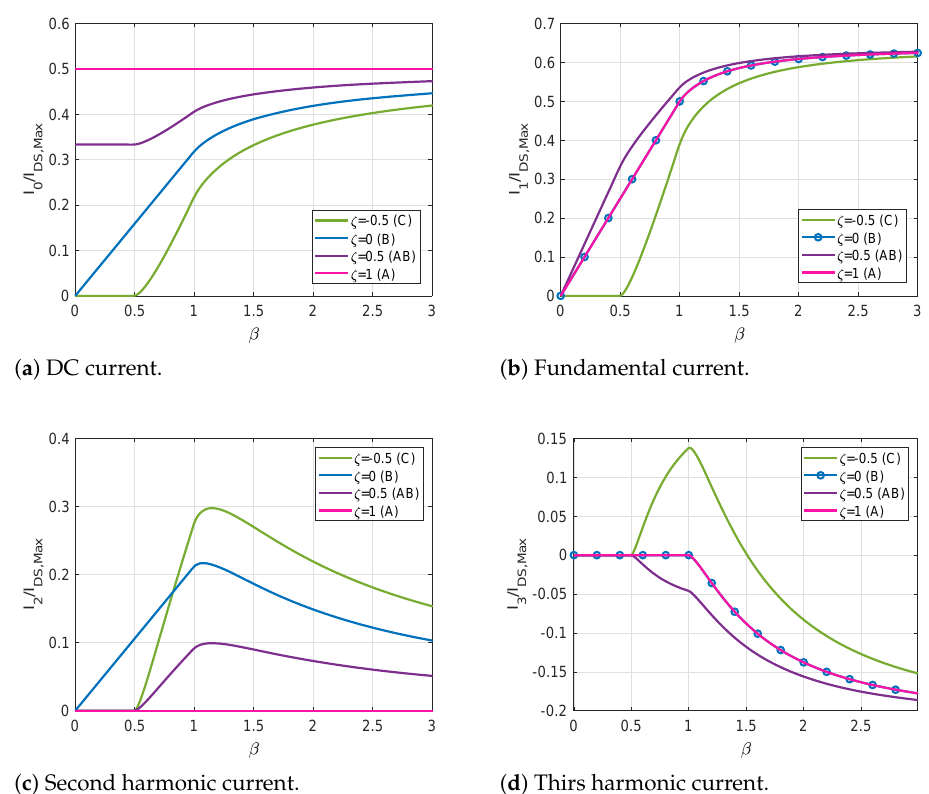
Figure 6. Normalized components of the drain-source current as a function of β